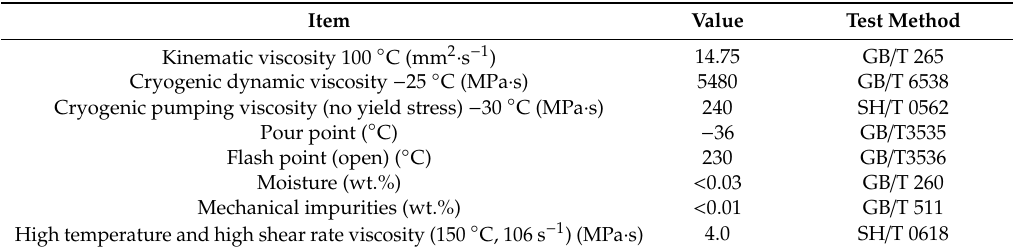
Table 2. General physical and chemical property of RP-4652D.